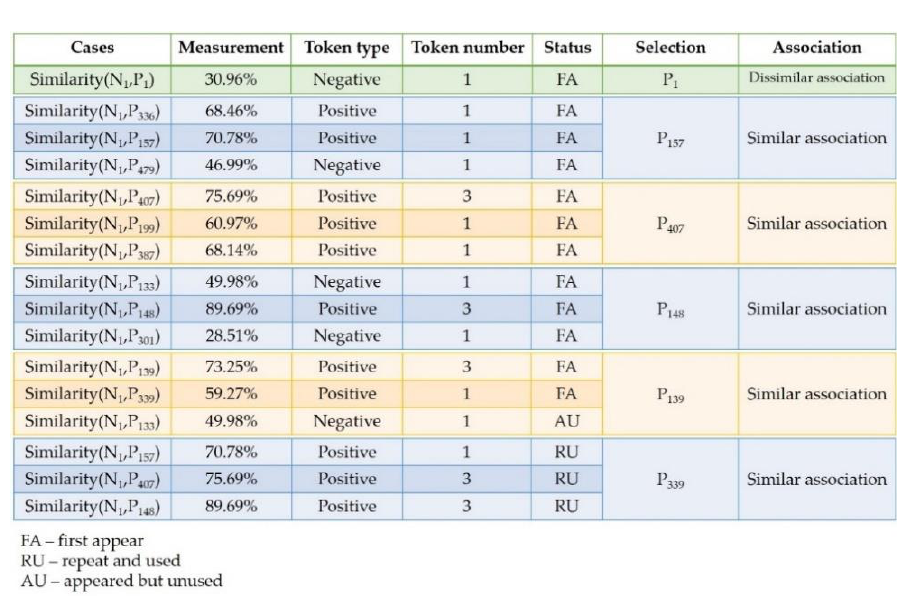
Figure 3. An example of the proposed case retrieval algorithm.